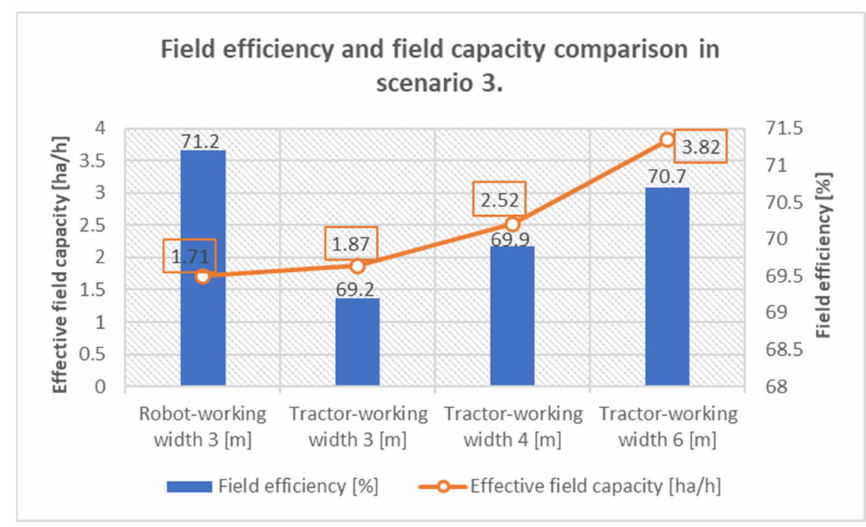
Figure 18. The comparison of field efficiency and field capacity for robot and tractor in scenario 3. According to Figure 19, the robot has up to 11% less fuel consumption than the tractor. Regarding oil consumption, the robot consumes less oil than the tractor with the same size of implementation but, the tractor with 6 m size of implementation, shows less oil consumption than the robot.